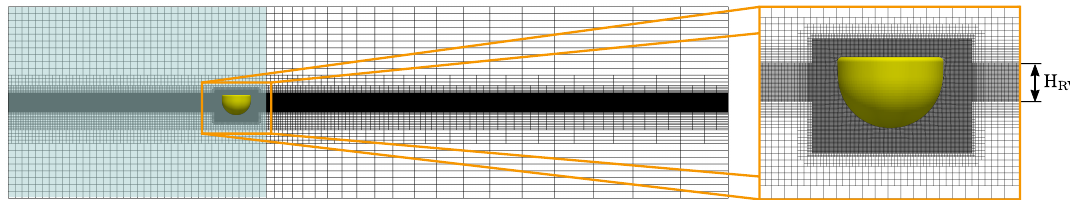
Figure 4. Screen shot of the computational mesh in the xz -plane. The simulation zone, in which the damping factor S = 0, is highlighted in